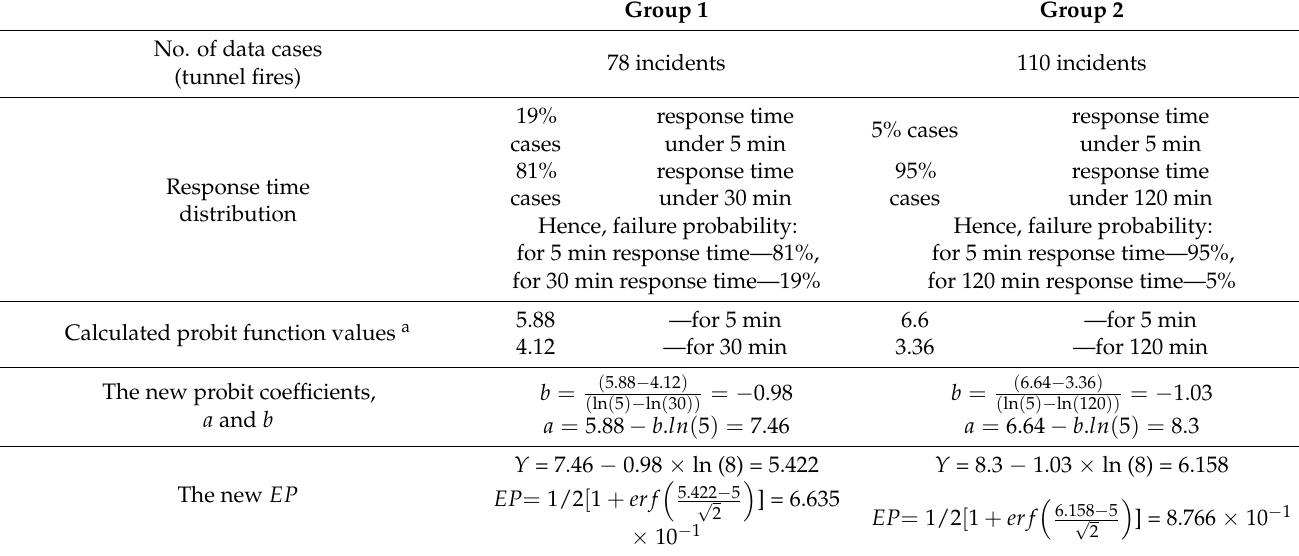
Table 6. Detailed calculations for uncertainty analysis based on incident data in real road tunnel fires